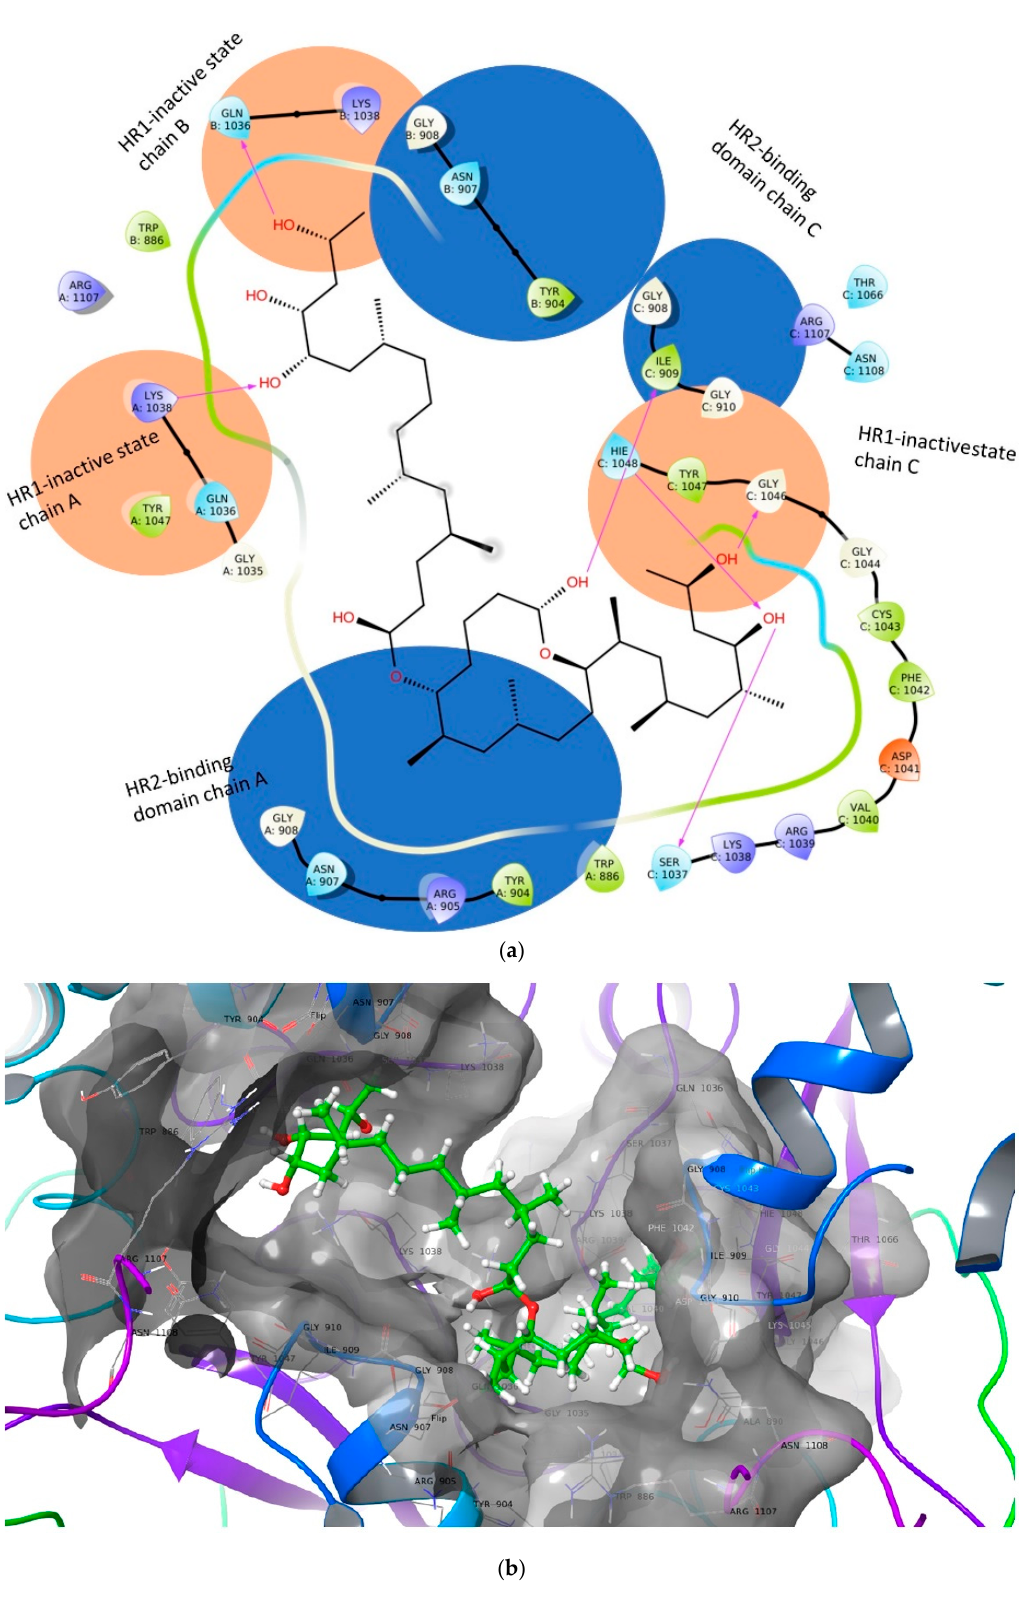
Figure 3. ( a ) Shows binding pocket in inactive HR1. The viral fusion domain activation involves the HR2 binding domain on HR1 to rearrange and pair with the HR2 region. ( b ) MLN A/B binding first stabilizes HR1 and second blocks the HR2 binding domain, preventing VFD